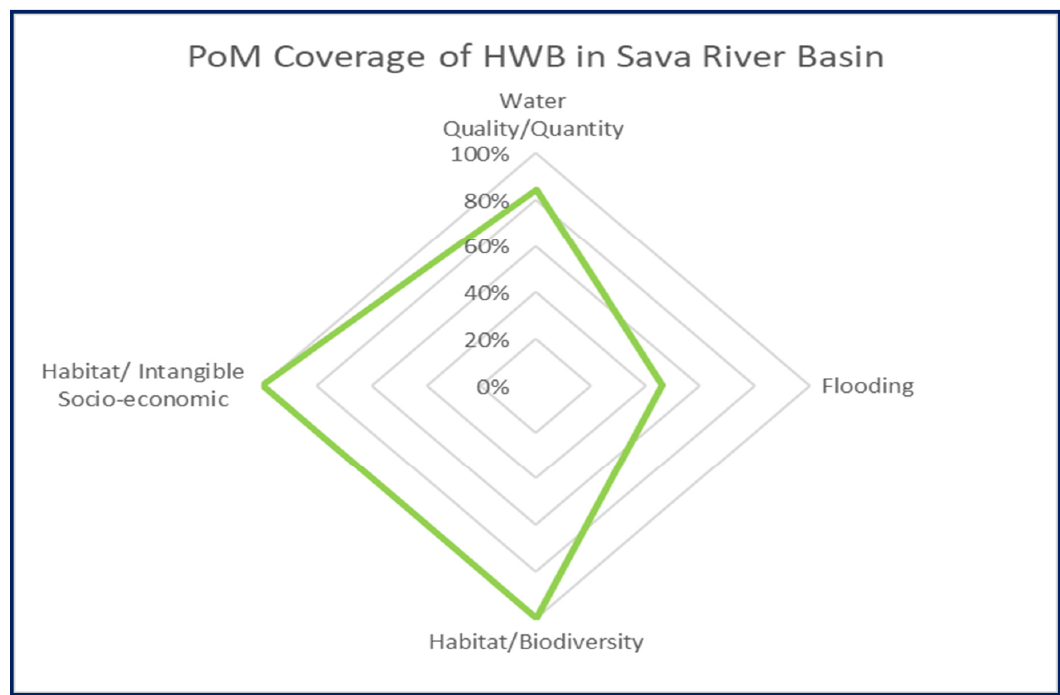
Figure 8. The coverage of HWB factors within the Sava River Basin.